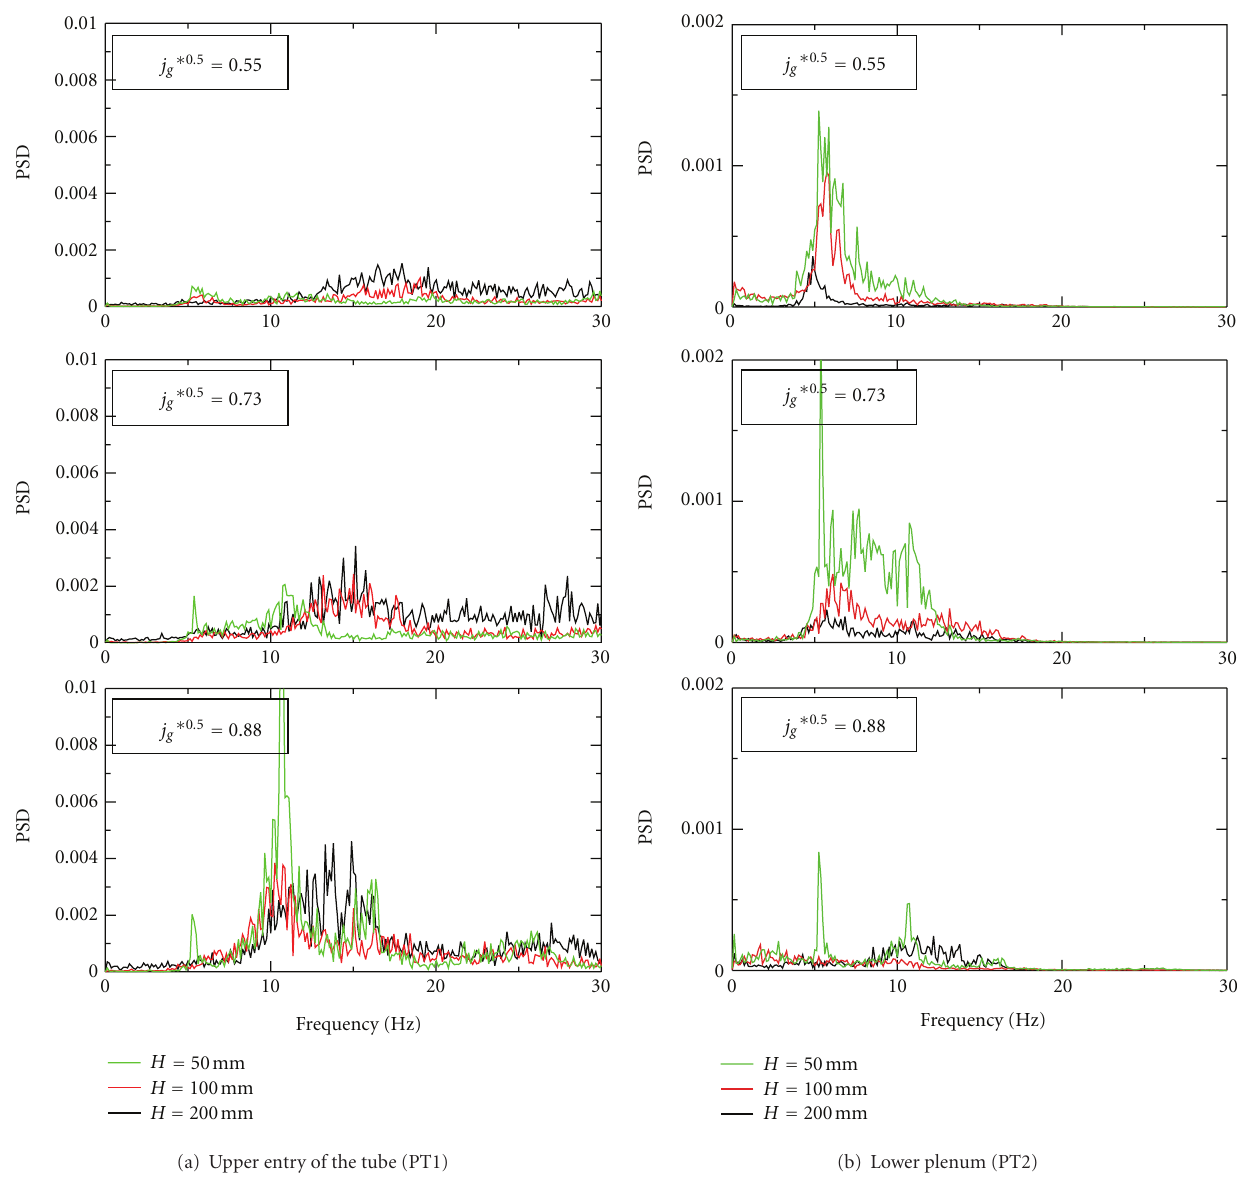
Figure 13: Power spectrum density (PSD) of pressure fluctuations for various air flow rates and water levels (tube diameter D = 12mm).